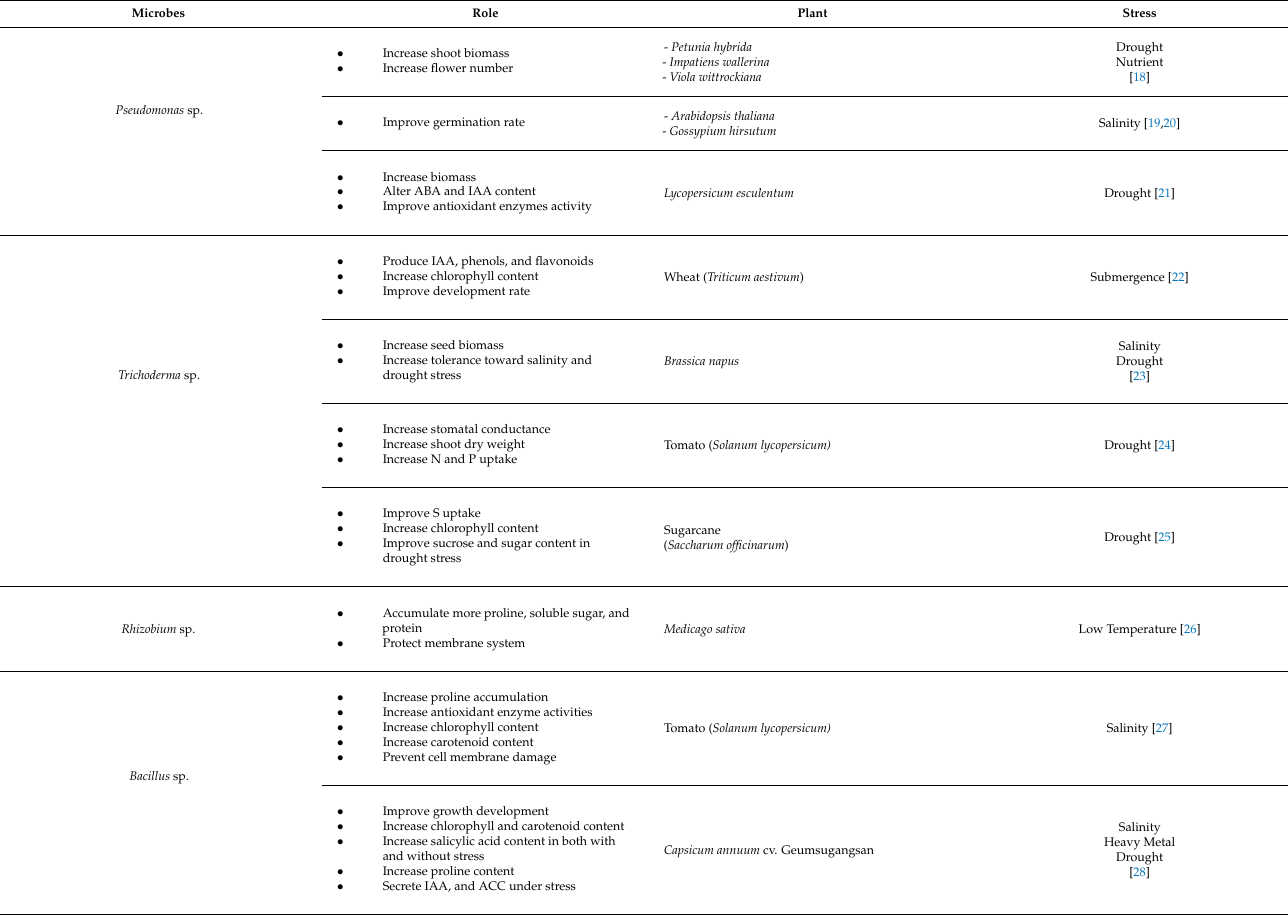
Table 1. The role of soil microbes in promoting growth in cultivated plants under abiotic stresses. Microbes